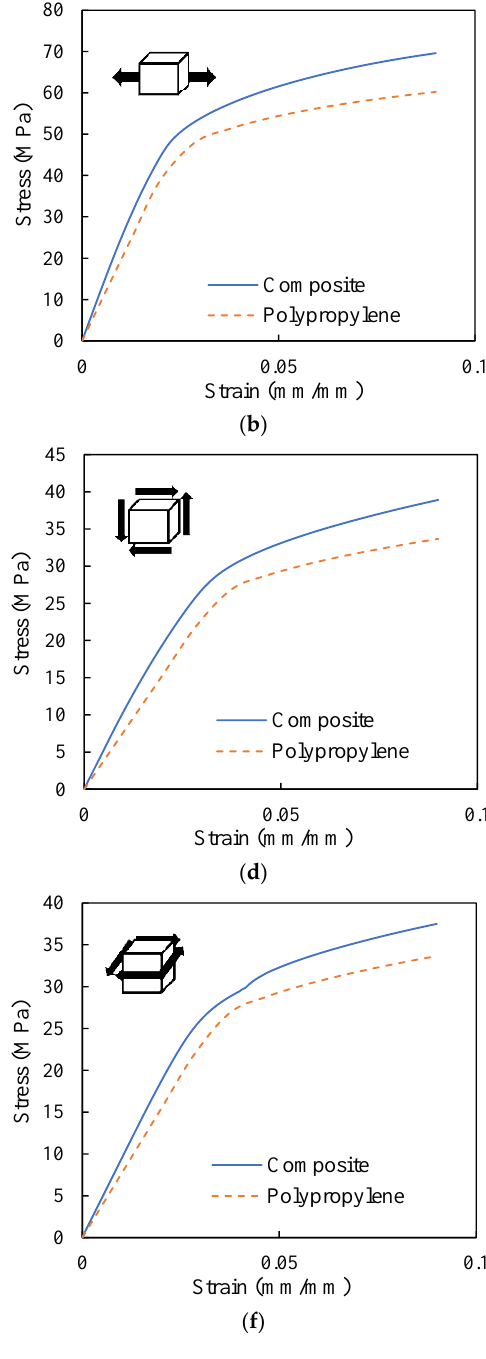
Figure 12. Stress-strain curve of the composite RVE under six periodic loading conditions compared with the pure PP; ( a ) 𝜎 11 − 𝜀 11 (wale direction); ( b ) 𝜎 22 − 𝜀 22 (course direction); ( c ) 𝜎 33 − 𝜀 33 (thickness direction); ( d ) 𝜎 12 − 𝜀 12 ; ( e ) 𝜎 13 − 𝜀 13 ; ( f ) 𝜎 23 − 𝜀 23 .